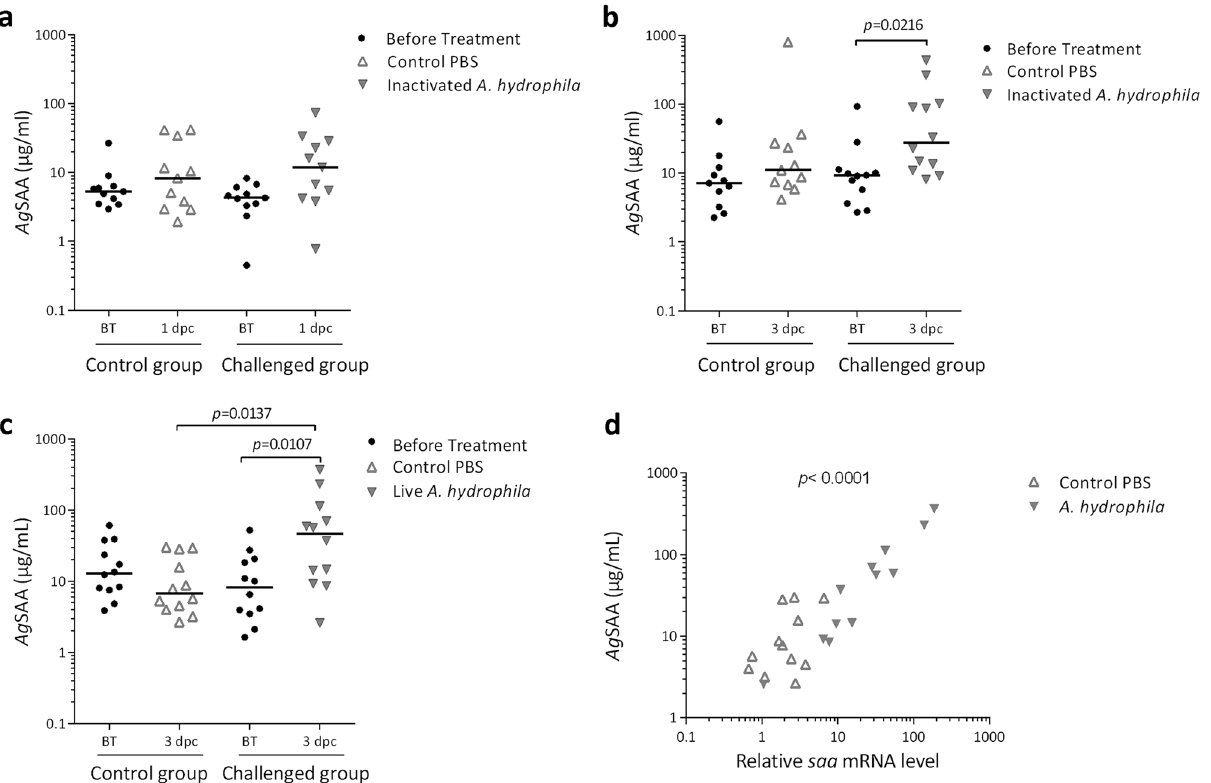
Figure 4. Serum Ag SAA levels in A. gueldenstaedtii challenged with heat-inactivated or live A. hydrophila. Experiment with heat-inactivated bacteria: juvenile Russian sturgeons were ip challenged with heat-inactivated A. hydrophila or sterile PBS (control PBS), and serum Ag SAA levels analysed at 1 dpc ( a ) or 3 dpc ( b ). Experiment with live bacteria: juvenile Russian sturgeons were ip challenged with live A. hydrophila or sterile PBS (control PBS), and serum Ag SAA levels analysed at 3 dpc ( c ). Individual and median values of serum Ag SAA levels (μg/ml) are indicated. Data were transformed to meet normality (using the inverse square